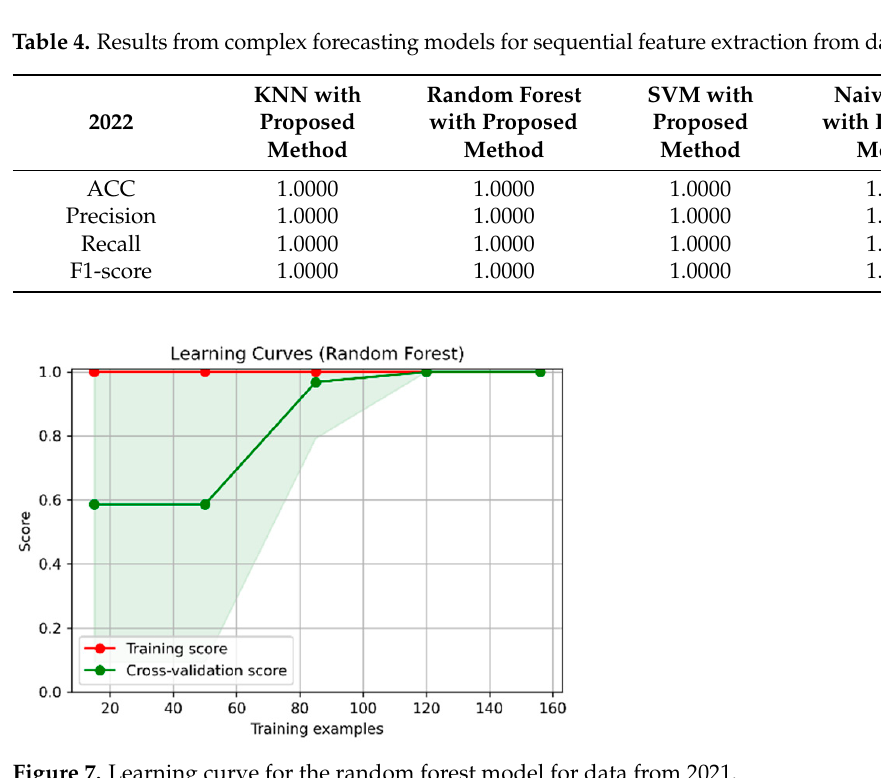
Table 3. Results from complex forecasting models for sequential feature extraction from data for 2021.